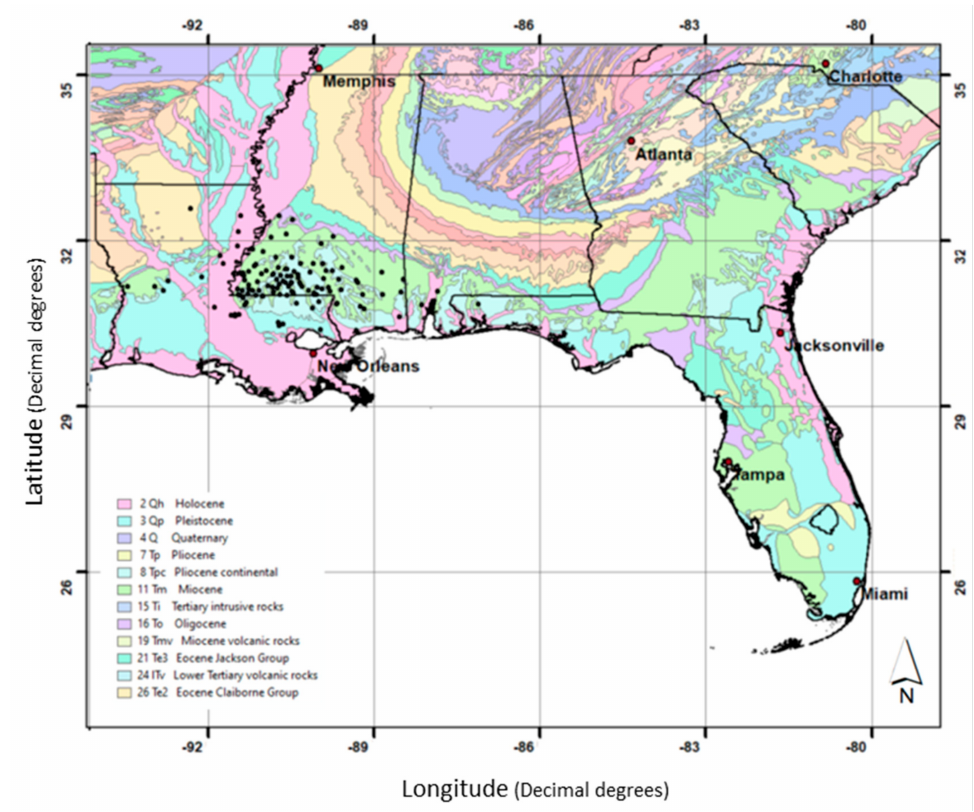
Figure 1. Spatial distribution of sampling points and geological formations (created in ArcGIS